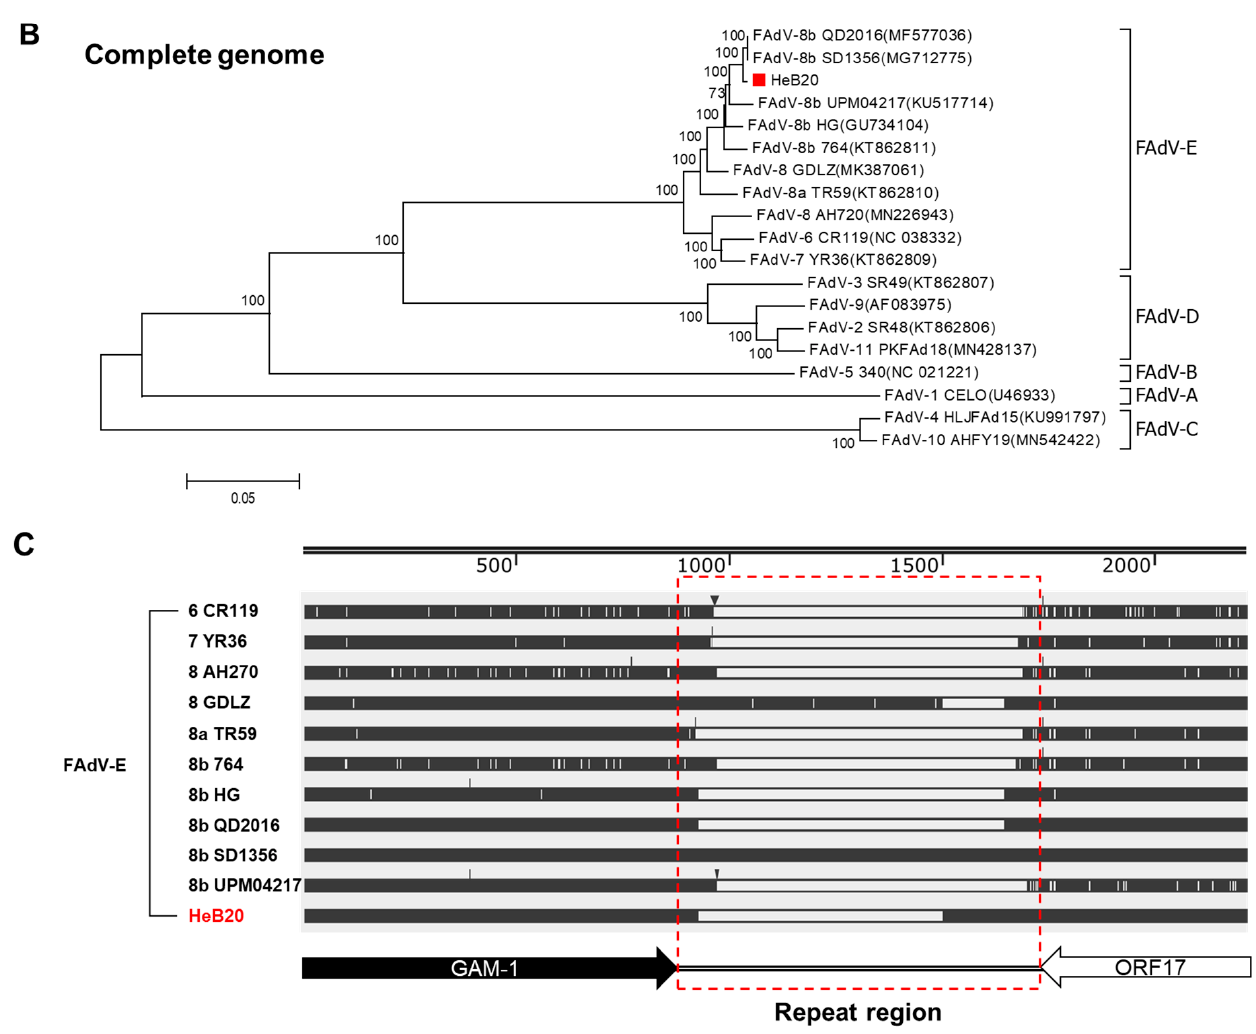
Figure 2. Schematic representation and phylogenetic analysis of HeB20. ( A ) Schematic representation of the HeB20 genome indicating the position of all 40 open reading frames. ( B ) Phylogenetic analysis of HeB20 based on whole-genome sequences. ( C ) Sequence analysis of the repeat region in FAdV-E.